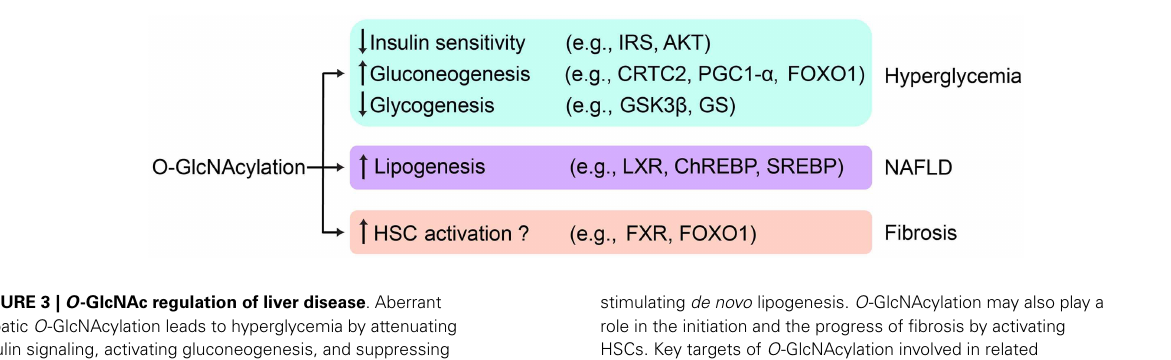
stimulating de novo lipogenesis. O -GlcNAcylation may also play a role in the initiation and the progress of fibrosis by activating HSCs. Key targets of O -GlcNAcylation involved in related pathways are